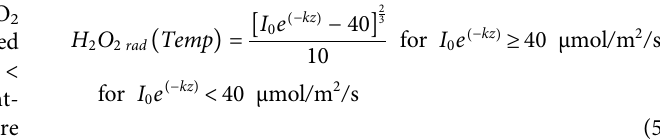
Frontiers in Environmental Science |